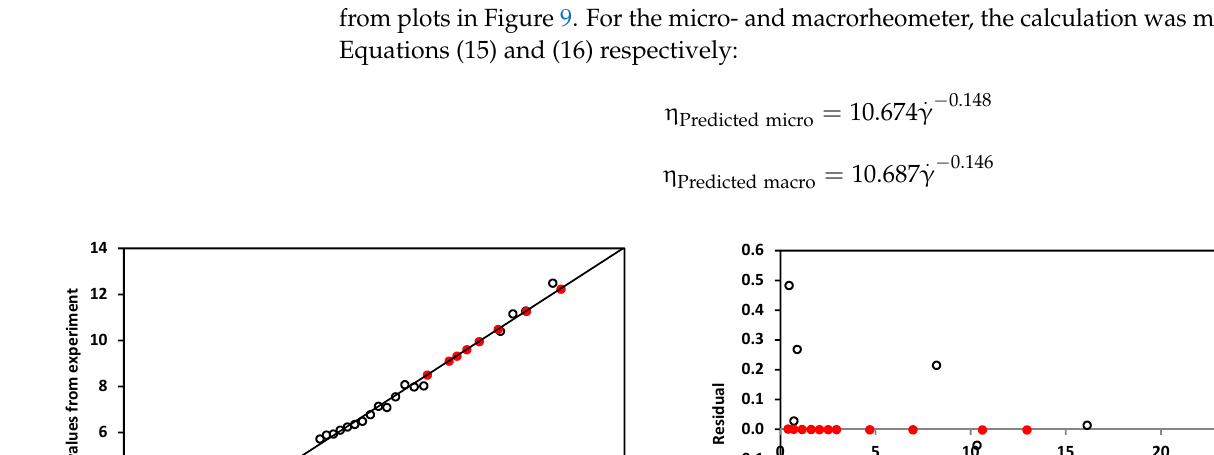
Figure 9. ( a ) Viscosity vs. shear rate of blood, a non-Newtonian fluid, at 50% Ht, 42% Ht, and 35% Ht. Blood at 42% Ht. using the macrorheometer (white circles). Viscosity vs. shear rate of plasma, a Newtonian fluid. ( b ) Viscosity vs. shear rate of non-Newtonian and Newtonian fluids in log–log scale.